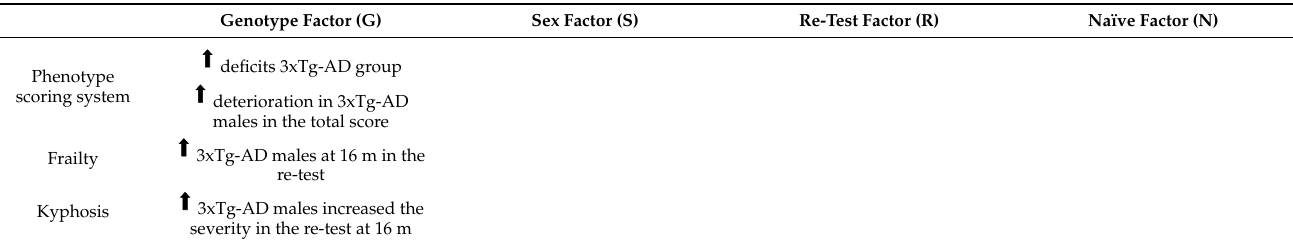
Figure 10. Functional correlations with phenotype score system. Pearson’s correlations analysis of phenotype score system. Meaningful, Pearson’s correlation between phenotype score system and ( A ) stride length in males, and ( B ) physical endurance — total in females. Statistics: Pearson r 2 , ** p < 0.01, * p < 0.05. There is the summary of results in Table 2. Table 2 . Summary of results.